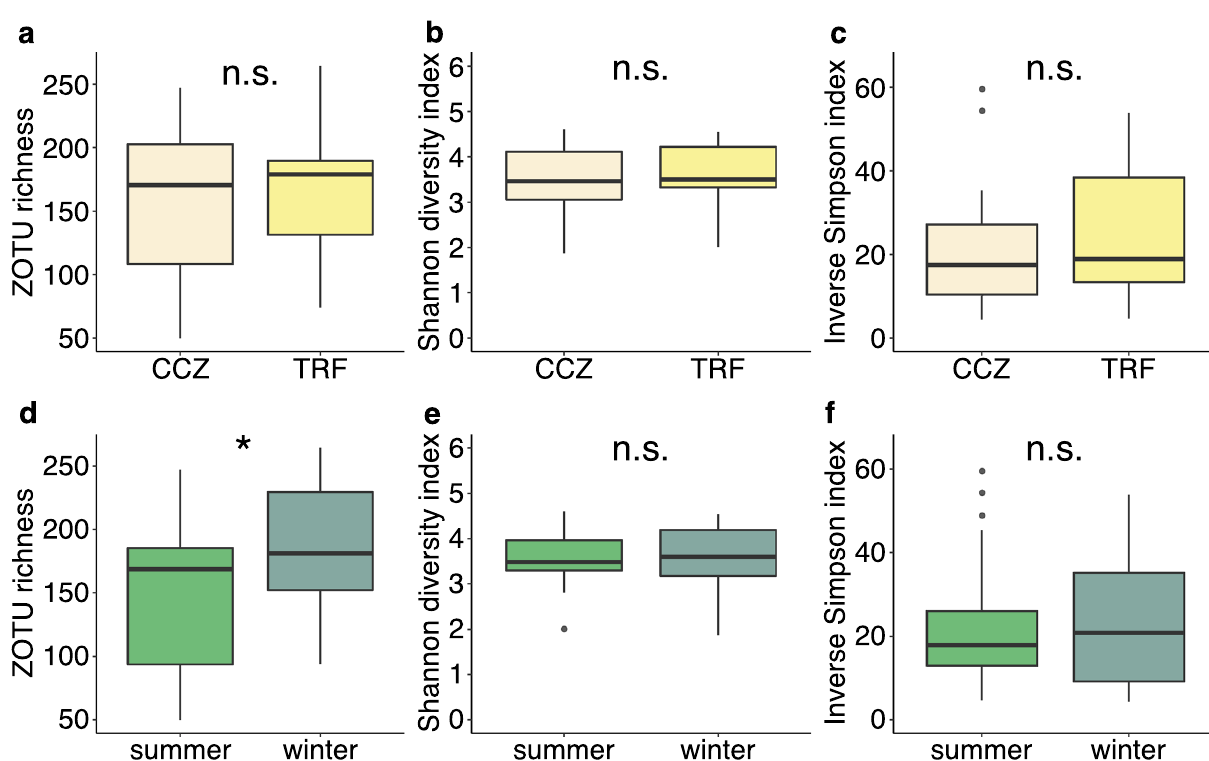
Figure 4. Alpha diversity indices. ( a ) ZOTU richness by site. ( b ) Shannon diversity index by site. ( c ) Inverse Simpson index by site. ( d ) ZOTU richness by season. ( e ) Shannon diversity index by season. ( f ) Inverse Simpson index by season. There was no interaction between sites and seasons ( p > 0.05; two-way ANOVA). n.s. denotes non-significant and * denotes significant at p < 0.05. The rarefied data were